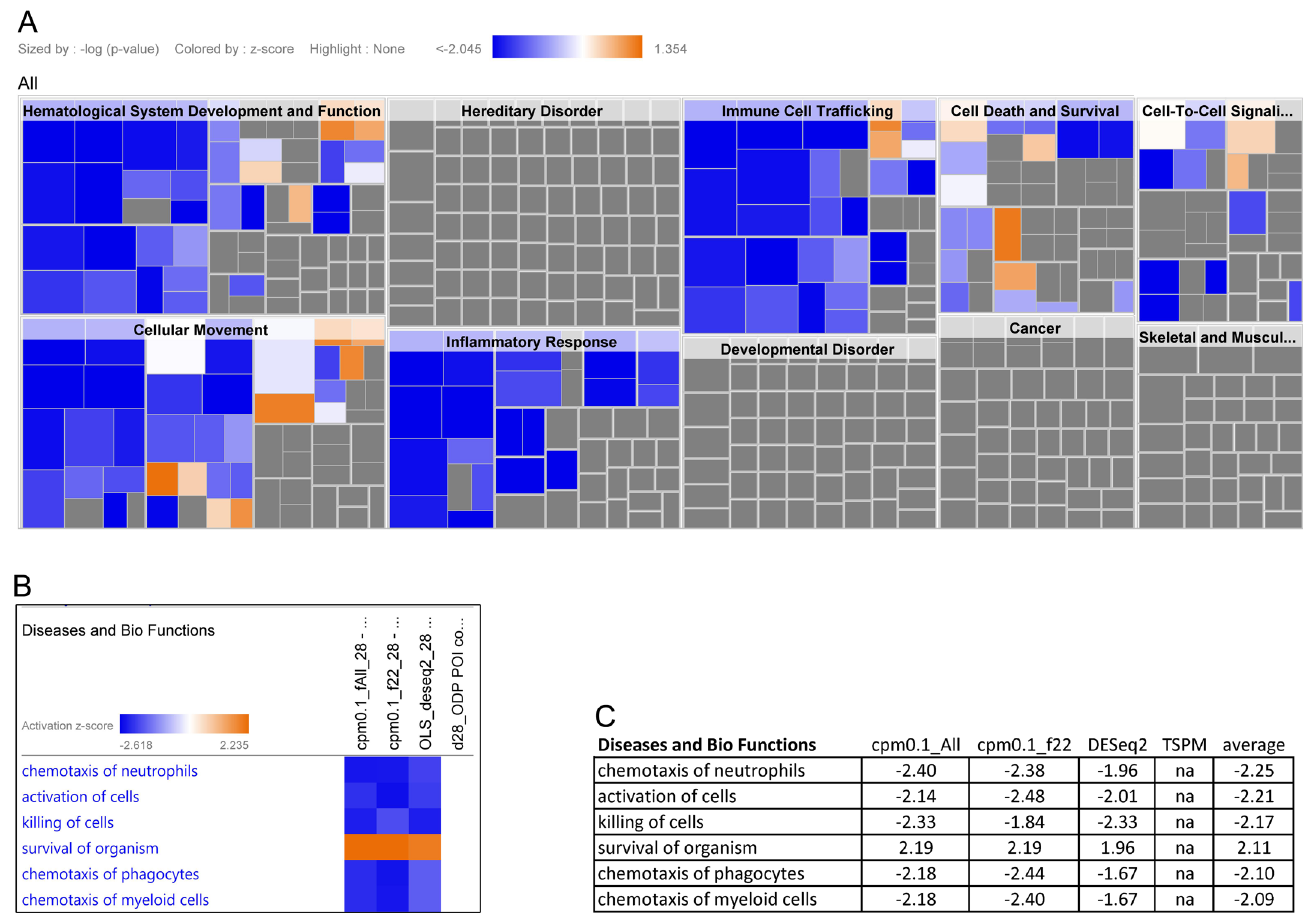
Fig 4. Downstream effect analysis (DEA) on whole blood cells of subjects consuming LGG for 28 days. (A).The visualization is a hierarchical heat- map generated from edgeR analysis with filtered data where the major boxes represent a family (or category) of related functions. Each individual colored rectangle is a particular biological function or disease and the color indicates its predicted state: Increasing (orange), or decreasing (blue). Darker colors indicate higher absolute Z-scores. In this view the size of the rectangle is correlated with increasing overlap significance (p-value). The image has been cropped for better readability. (B) Heat-map comparison of Diseases and Biofunctions affected across all 4 analysis (edgeR 0.1 cpm/all, edgeR 0.1cpm/ 22, DESEq2, TSPM). Similarly color represents predicted state. (C). Individual Z-scores and mean Z-scores per each Bio Function affected. The Z-score algorithm is designed to reduce the chance that random data will generate significant predictions. Negative Z-scores indicate a down-regulation of Biofunction, positives Z-scores indicate an up-regulation of function. Absolute Z-score values higher than 2.0 can be used to make biological predictions.